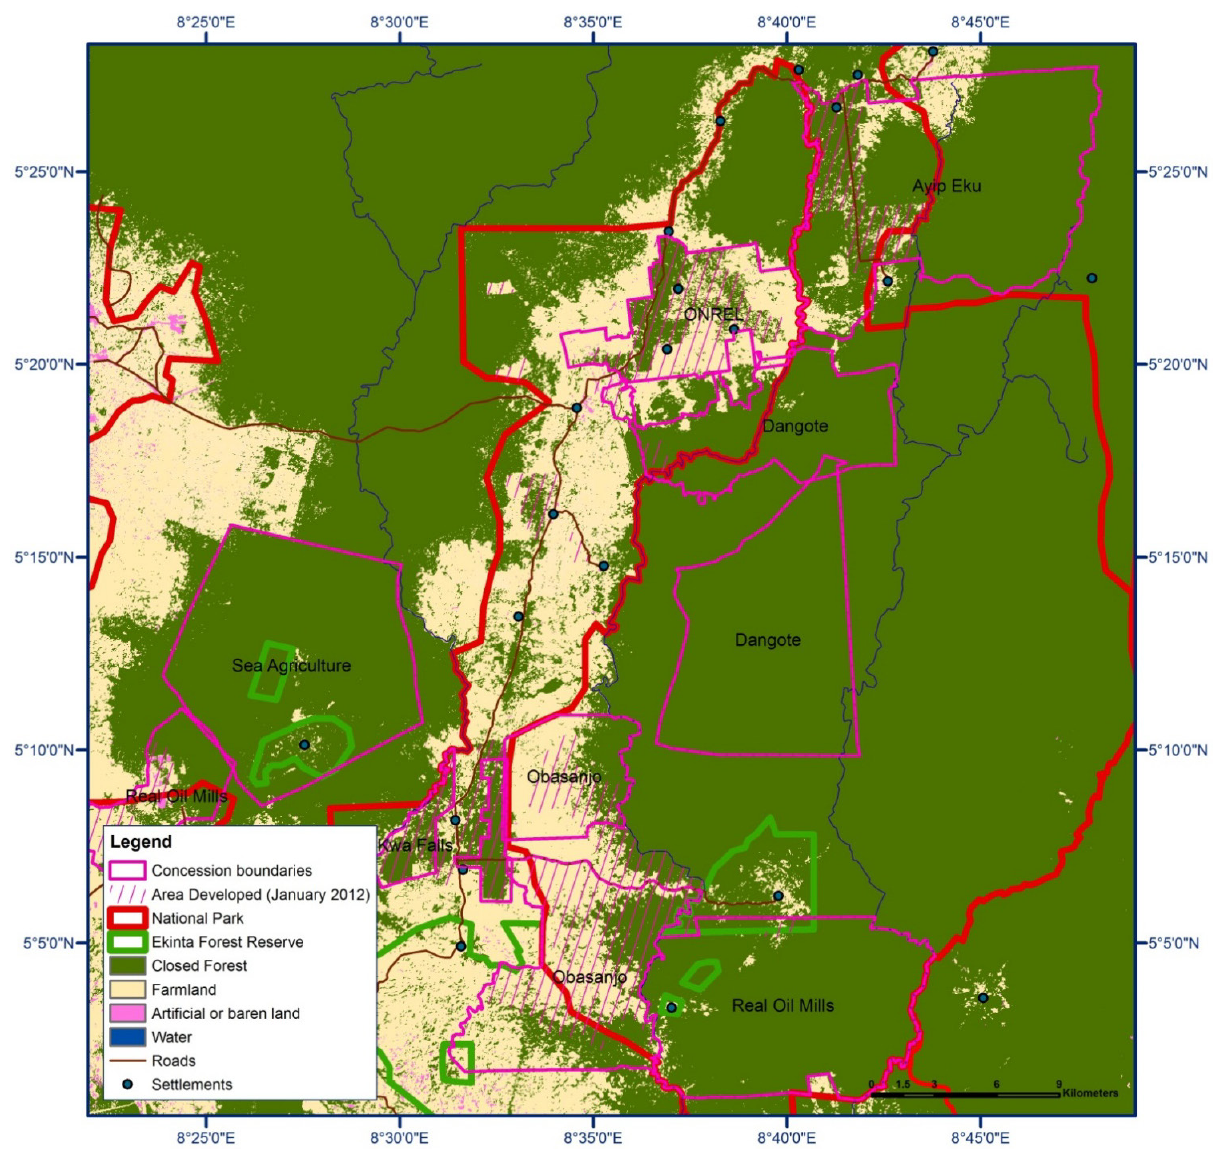
Figure 1. Land use within the Oban-Korup forest block. Source: Author’s representation, based on NASA Landsat 5 satellite imagery (30 m resolution), Spot Image satellite imagery (5 m resolution), Field Research, CRS cadastral maps, and CRS Forestry Commission protected area maps. Reproduced from Schoneveld [38]; Note: “Areas developed” are those areas that have been converted for investment purposes by January 2012. “Artificial areas” are typically settlement and industrial development